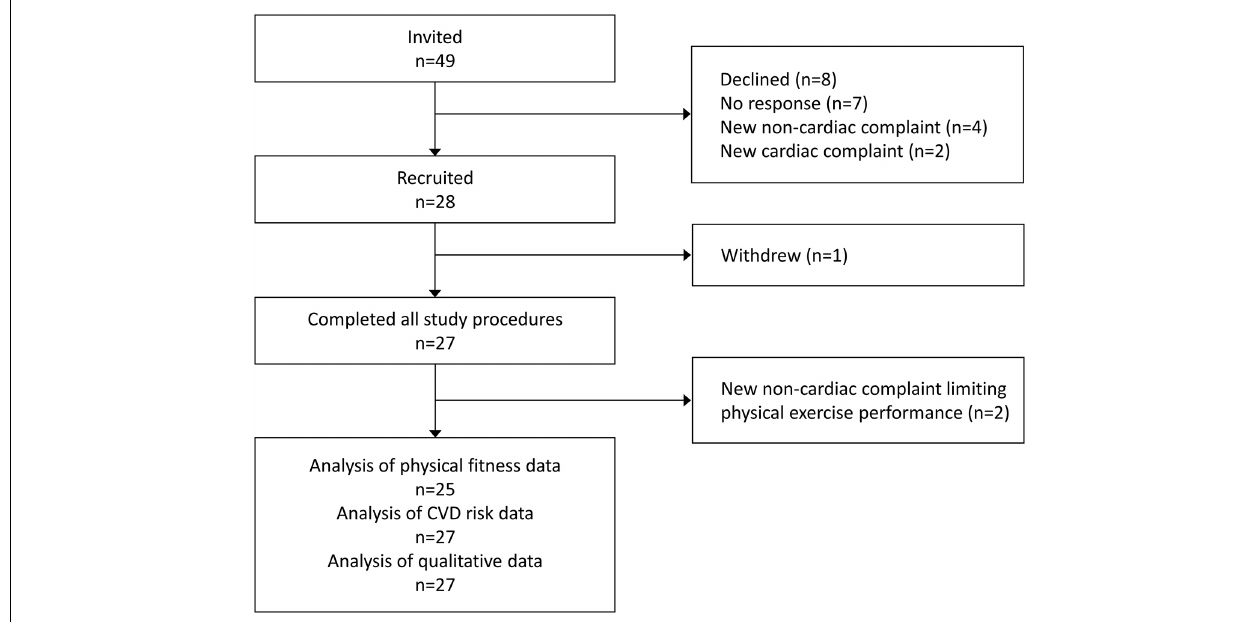
FIGURE 1 | Study flow diagram.